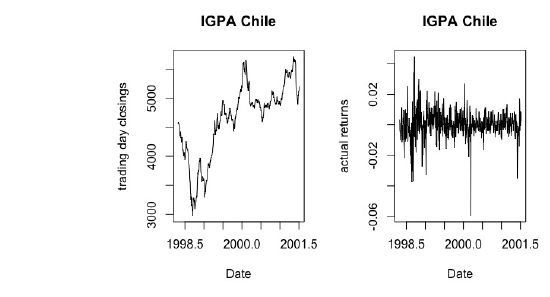
Figure 3. Plots of trading days closings and actual returns of HSI and IGPA.